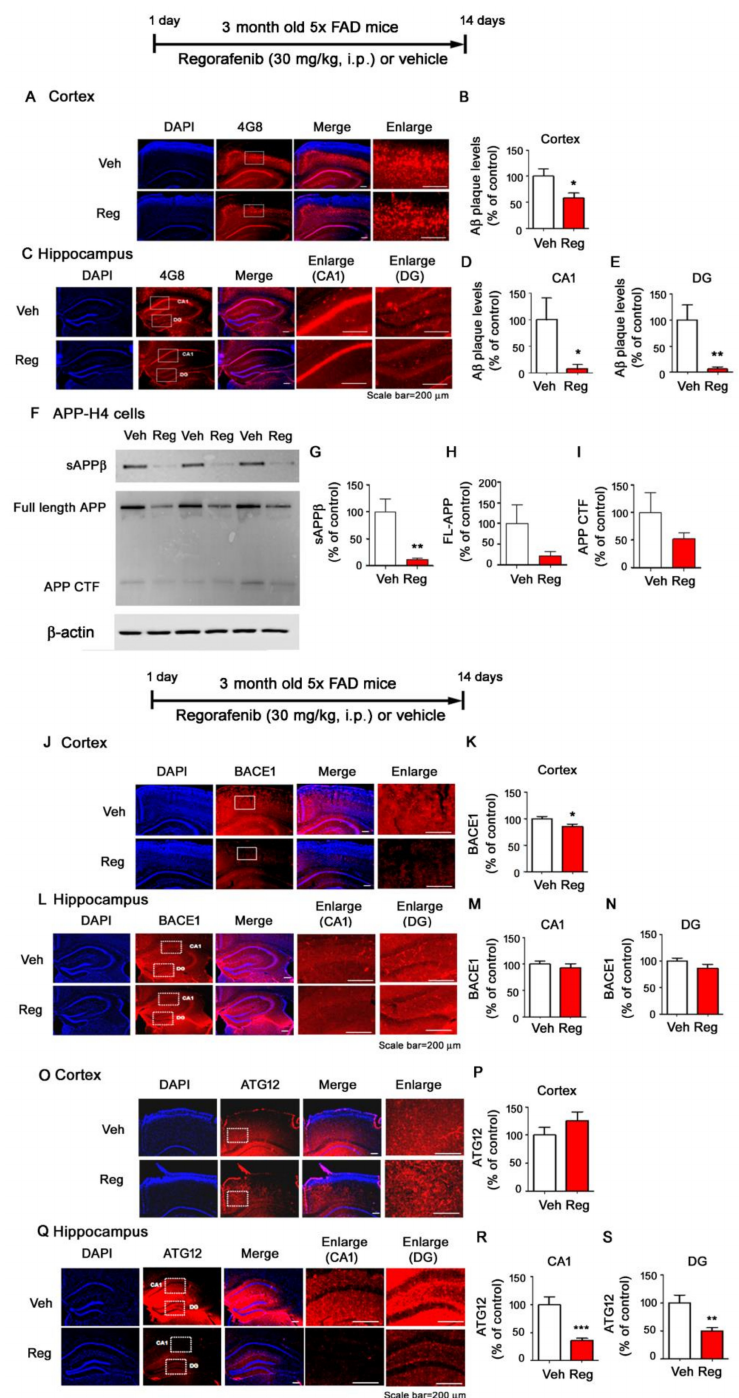
Figure 7. Amyloid plaque levels are significantly decreased in the brains of regorafenib-injected 5x FAD mice. ( A – E ) 5x FAD mice were injected with regorafenib (30 mg / kg, i.p.) or vehicle (2% DMSO + 30% PEG + 5% Tween 80) daily for two weeks, and immunohistochemistry was performed with an anti-4G8 antibody (n = 4 mice / group). ( F – I ) APP-H4 cells were treated with regorafenib (5 µ M) or vehicle (1% DMSO) for 24 h, and western blotting was conducted to measure sAPP β , full-length APP, and APP CTF levels (n = 6 / group). ( J – S ) 5x FAD mice were injected with regorafenib (30 mg / kg, i.p.) or vehicle (2% DMSO + 30 % PEG + 5 % Tween 80) daily for two weeks, and immunohistochemistry was performed with anti-BACE1 ( J – N , n = 4 mice / group) or anti-ATG12 antibodies in the cortex and hippocampus ( O – S , n = 5 mice / group). * p < 0.05, ** p < 0.01, *** p <